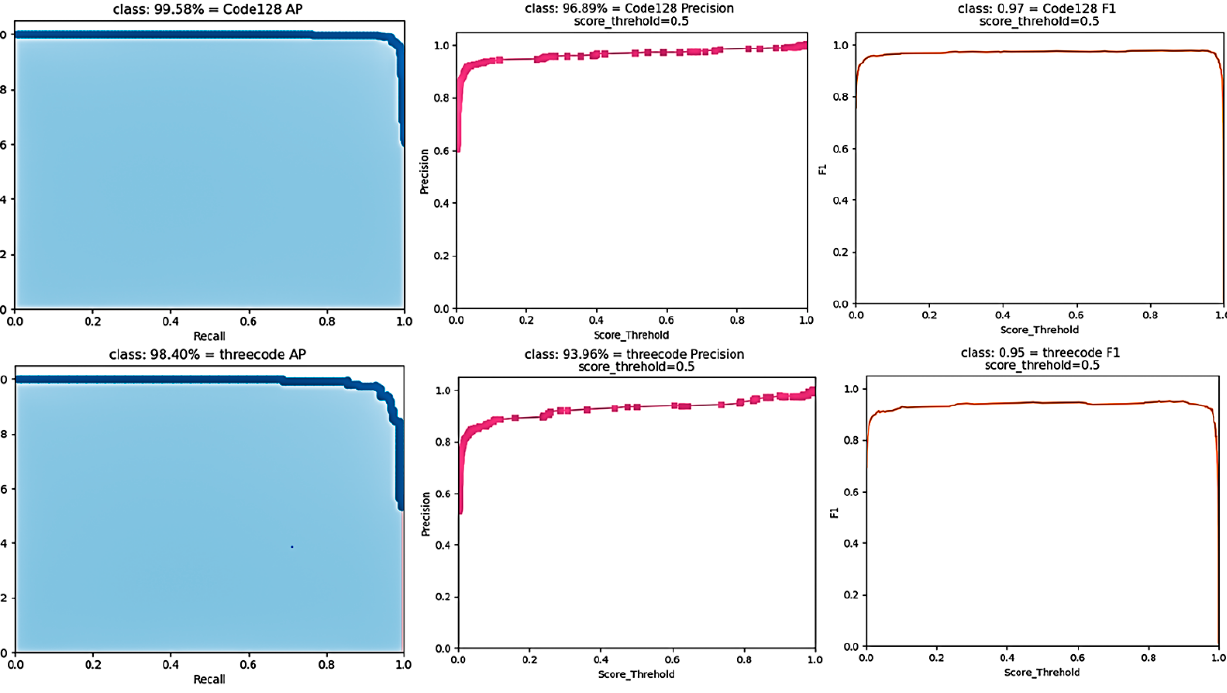
174 Table 3. Comparison of model performance after optimization (three-segment code). Model